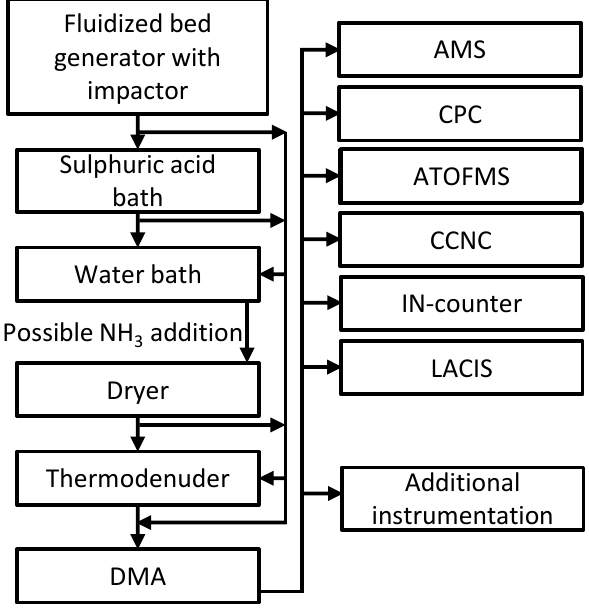
Fig. 1. Experimental set-up of the FROST campaigns. The sections between the Fluidized bed generator and the DMA can be